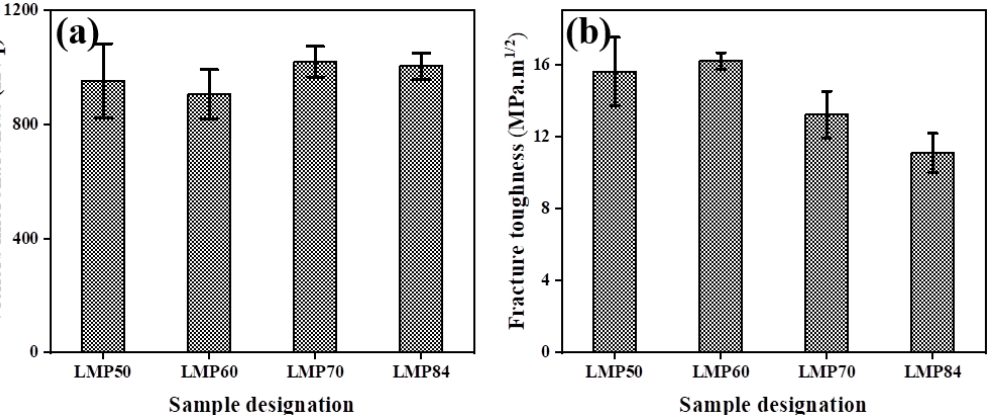
Figure 7. Mechanical properties micrograph of TiC-based cermets fabricated as a function of laser melting peak by the SLM process ( a )Vickers microhardness and ( b ) fracture toughness.